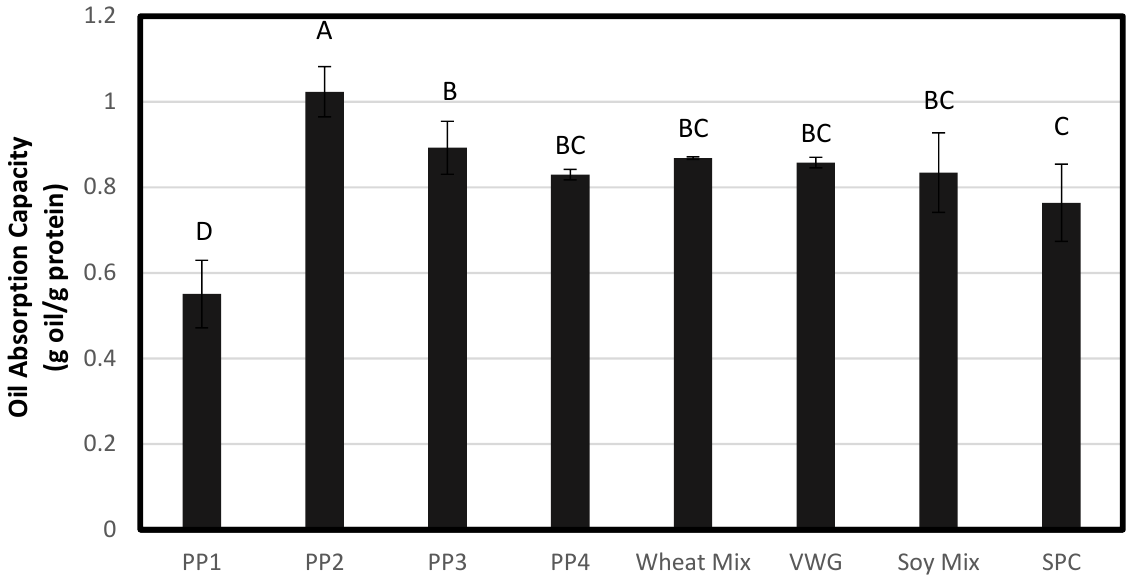
Figure 3. Raw material average oil absorption capacity for all treatments. Bars denoted by the same letter are not significantly different ( p < 0.05).